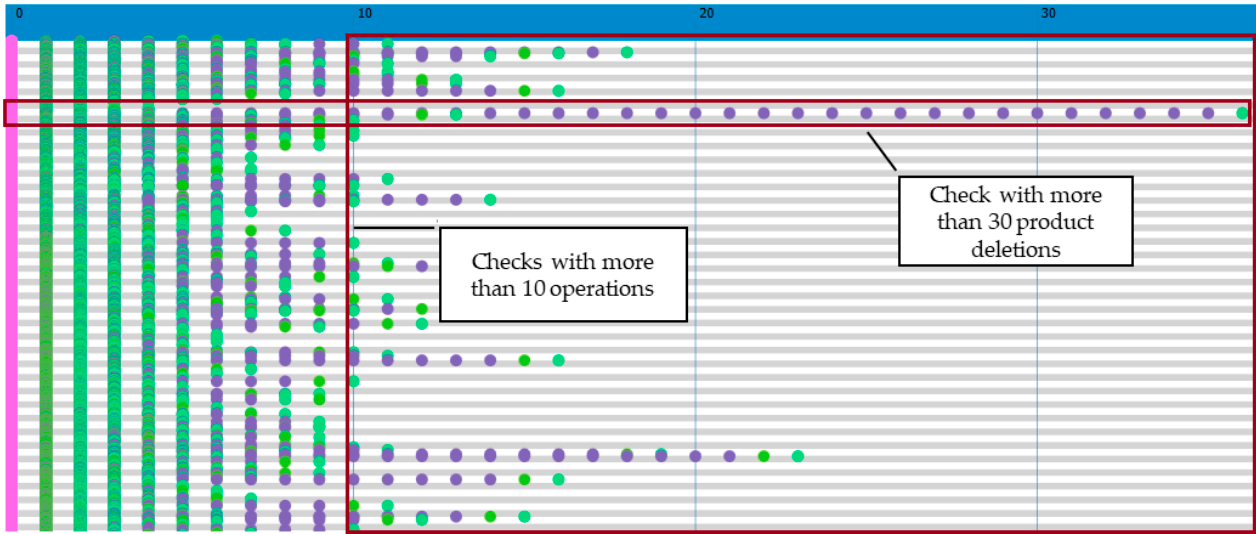
Figure 10. View by instances of the number of operations performed on